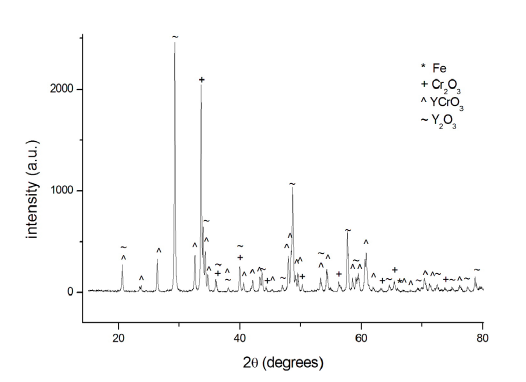
O coated Fe20Cr alloy specimen 2 3